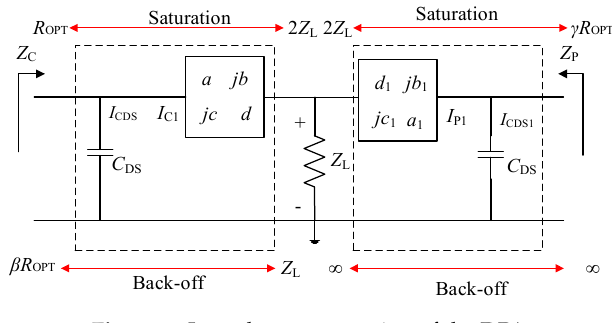
Figure 6. Impedance conversion of the DPA.